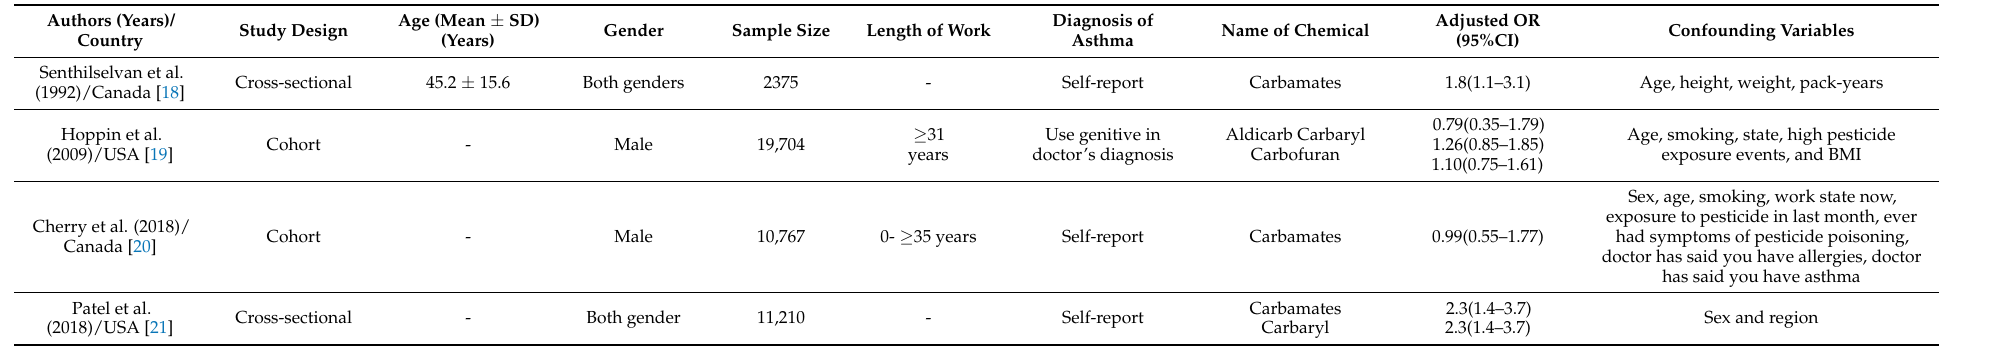
Table 2. The characteristics of studies evaluating the association between exposure to carbamates and asthmatic